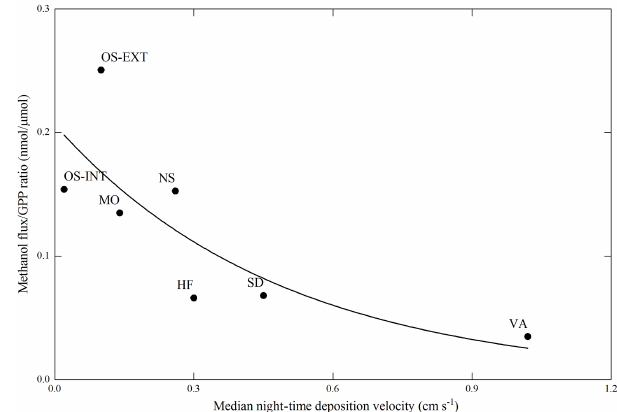
Figure 6. Methanol flux to GPP ratio as a function of the median night-time deposition velocity. The solid line represents an expo- nential fit ( r 2 =